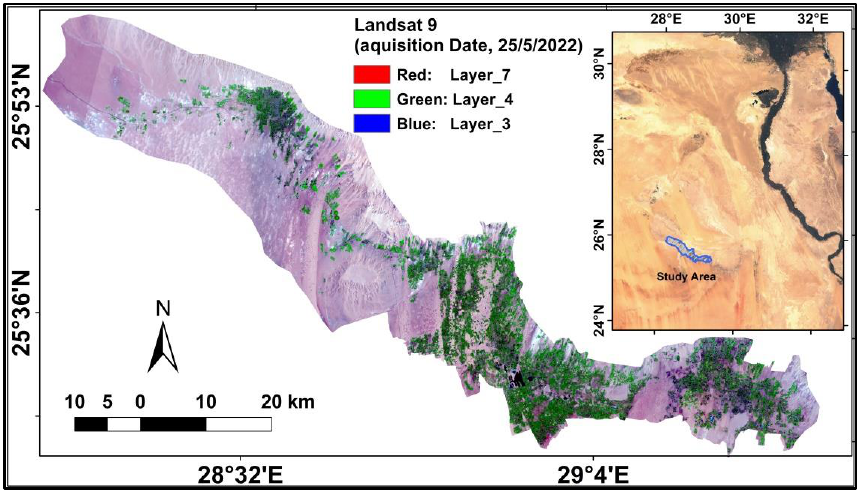
Figure 1. Location map of the study area.